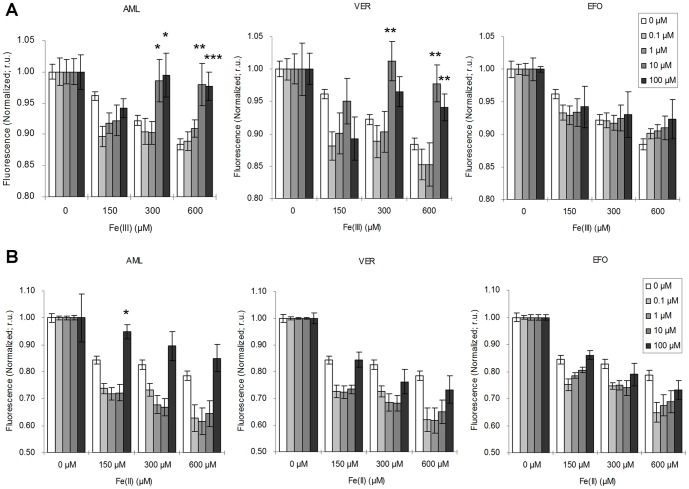
Iron blockade effects of LTCC and TTCC blockers on iron-overloaded cardiomyocytes.In this CALG-AM fluorescent assay, HL-1 cells were pretreated with LTCC blockers, amlodipine (AML) and verapamil (VER), and TTCC blocker, efonidipine (EFO), at logarithmic scale from 0.1 to 100 µM. 3 indicated doses of Fe(III) (A) and Fe(II) (B) were loaded 30 min after blocker treatment. Fluorescence readings were at 70 min after iron loading. Fluorescence signal changes were normalized to respective negative controls of each treatment arm. *p<0.05; **p<0.01; ***p<0.001. The results represented as mean ± SEM of four independent triplicate experiments.